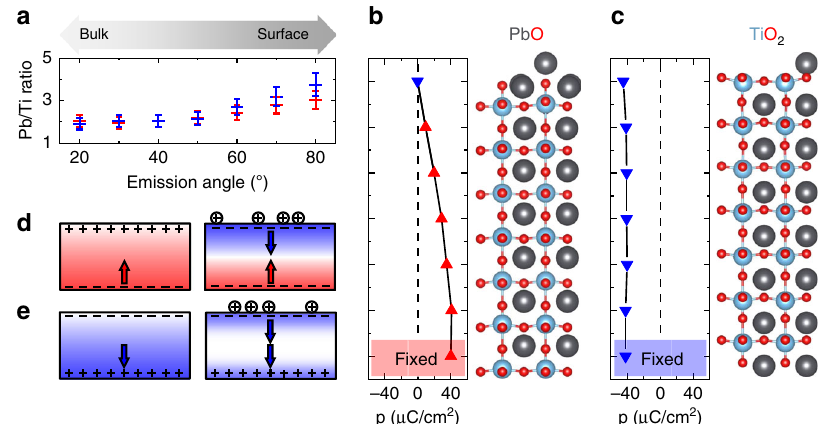
Fig. 3 Competitive and cooperative con fi gurations explored by XPS and DFT. a Pb/Ti atomic ratio at XPS emission angles (20 – 80) ∘ , higher angles displaying a higher sensitivity to the sample surface lower angles. Red and blue symbols correspond to the samples with suppressed and enhanced polarization, respectively. The error bar is based on the estimated experimental accuracy (see “ Methods ” ). b , c Density-functional calculations of dipole moments (p) perpendicular to the bottom interface in PTO heterostructures with a Pb adatom on the surface. The polarization direction is imposed at the bottom interface to match with our experiments by fi xing the dipole moment of the fi rst u. c. in the calculation (marked as “ fi xed ” ). The atomic positions in heterostructures with ( b ) PbO and ( c ) TiO 2 top-interface termination and their ionic positions are depicted on the right-hand side of the graph. d , e Sketch of the competitive and cooperative interfaces for the transient (left) “ single-interface ” and the persistent (right) “ combined-interface ” regime. The favored polarization direction at each interface is indicated with arrows and the resulting bound charges are represented with “ + ” and “–” signs. The additional positive charges at the top interface introduced to emulate the non-stoichiometry are shown as “ ⨁ ” .